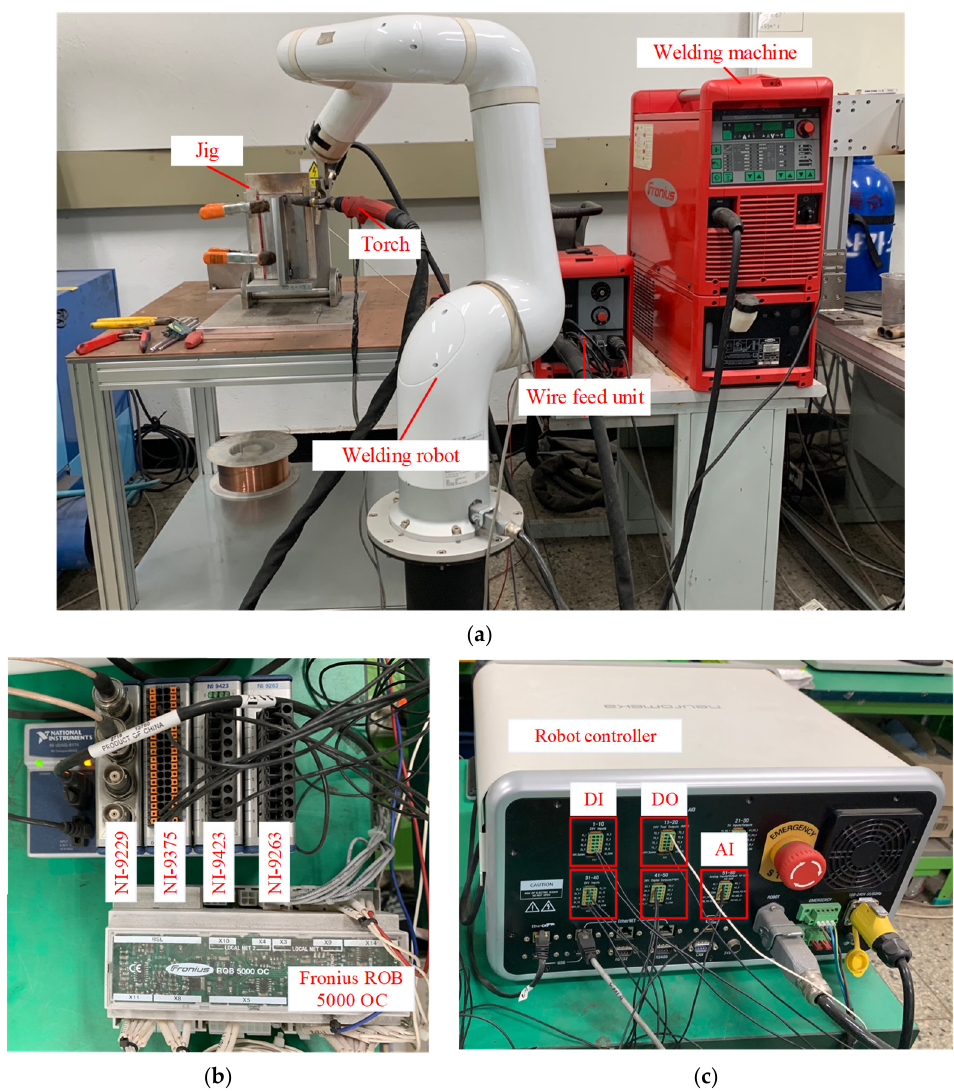
Figure 2. Experimental equipment: ( a ) welding robot and welding machine, ( b ) NI modules and ROB 5000 OC, and ( c ) robot controller.